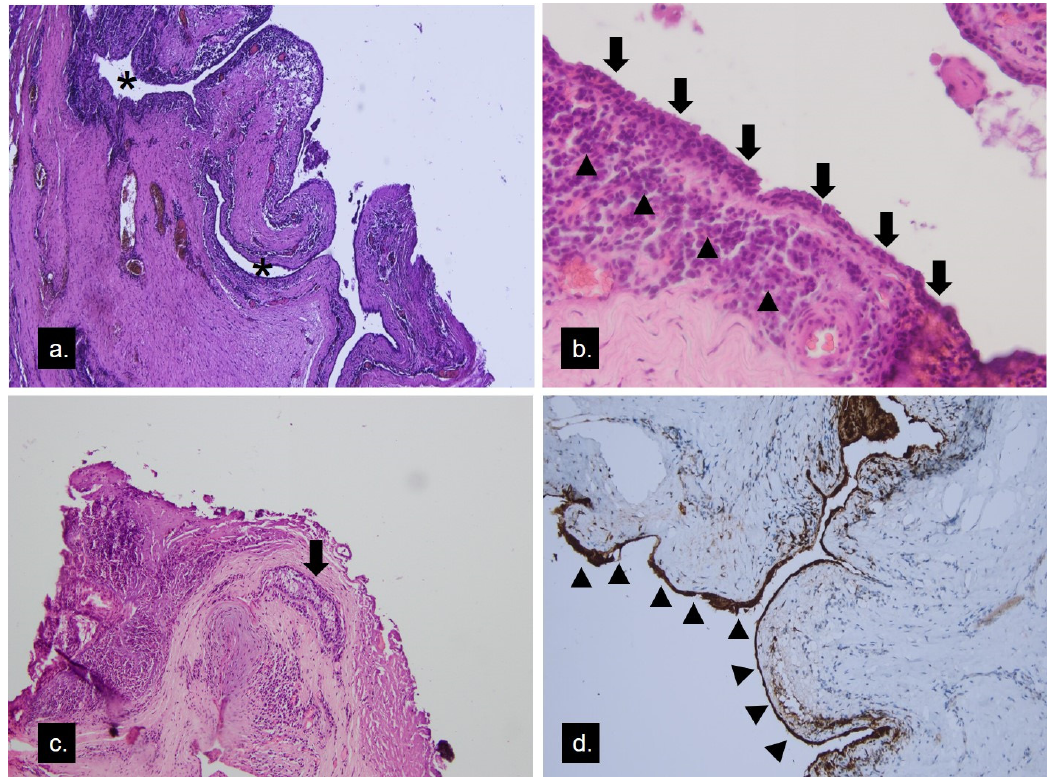
Figure 4. Histopathology of the apocrine hidrocystoma. ( a ) Microscopically, multilocular cystic le- sions lined with bilayered cells were seen (asterisk) ( hematoxylin–eosin, original magnification ×40). ( b ) Apocrine cells formed the epithelium (arrow), and focal inflamed stroma showed lympho- plasmacytic infiltration (arrowhead) (hematoxylin–eosin, original magnification ×100). ( c ) One lob- ule of the sebaceous gland (arrow) in the cyst wall ( hematoxylin–eosin, original magnification ×40). ( d ) The lining cells showed GCDFP-15 positivity (arrowhead), a marker of apocrine epithelium.